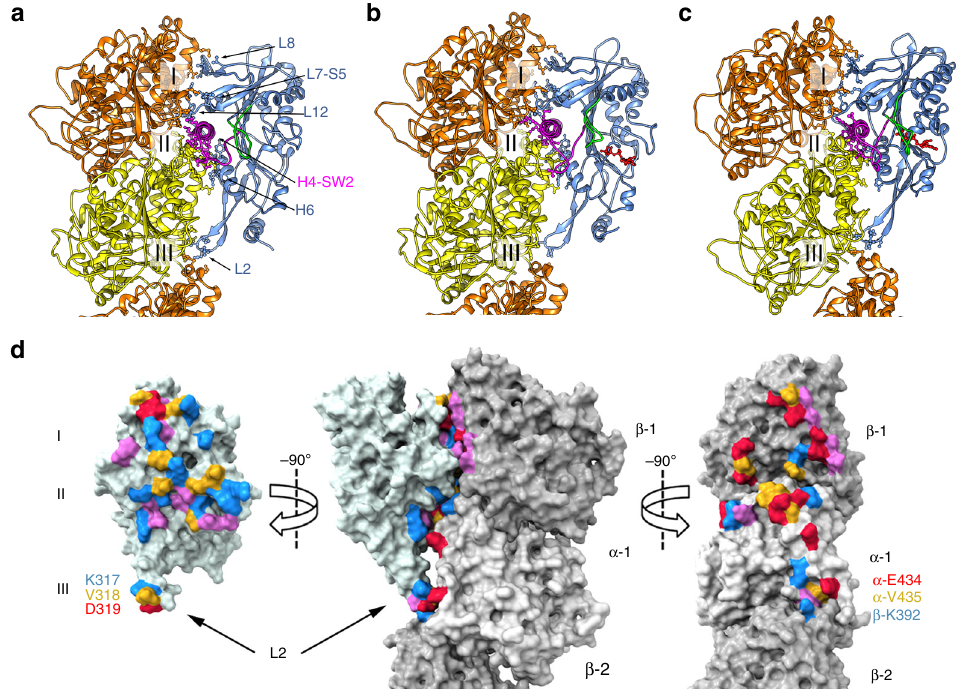
Fig. 4 a – c KLP10A-tubulin binding interface. Side views of the complexes indicating KLP10A secondary structure elements making contact with tubulin in the three areas of interaction (I – III). a NMMT apo . b NMMT AMP-PNP . c CTMMT AMP-PNP . KLP10A in blue, SW1 in green, SW2-H4 in magenta, AMP-PNP in red, β -tubulin in orange, α -tubulin in yellow. d Solvent accessible surface of the CTMMT AMP-PNP complex highlighting residues at the tubulin KLP10A interface within contact distance (speci fi c residues making contacts are listed in Supplementary Fig. 5). Residues are color coded according to type. Negative red, positive blue, polar magenta, and non-polar